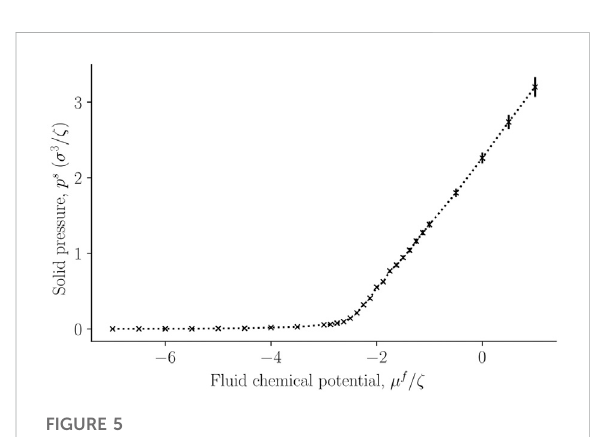
FIGURE 5 The solid pressure, p s , in a single sphere, calculated from Eq. 21 as a function of the fl uid chemical potential μ f of the surrounding fl uid.